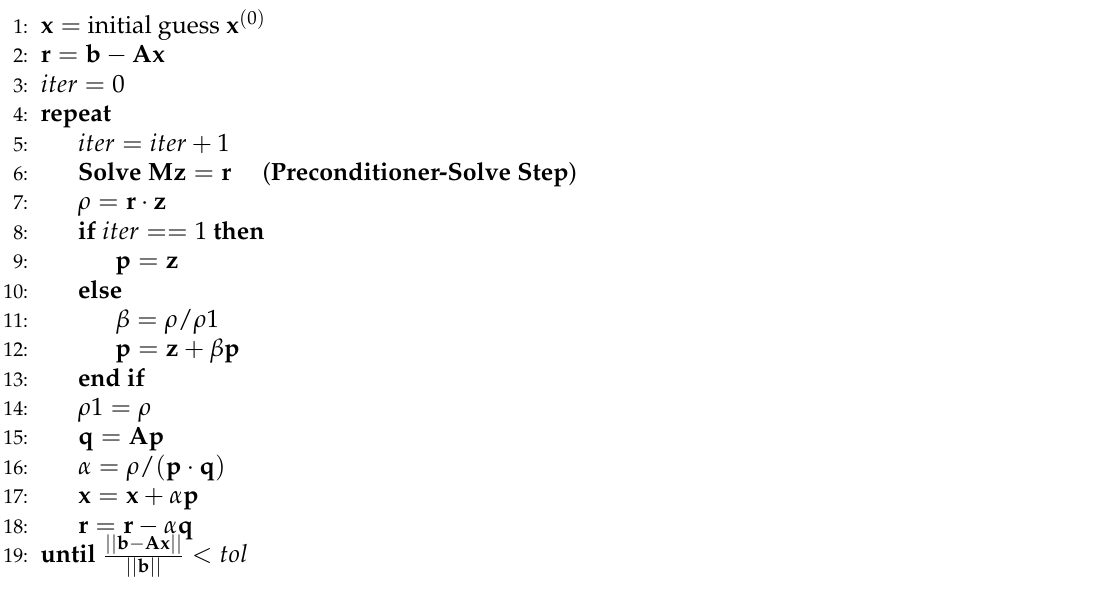
Algorithm 1 Preconditioned conjugate